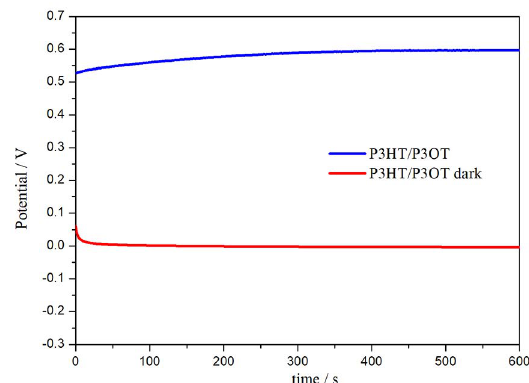
Figure 5. Open circuit potential obtained for the ZnO solar cells with P3HT/P3OT copolymer in under illumination of 100 mW cm -2 and without